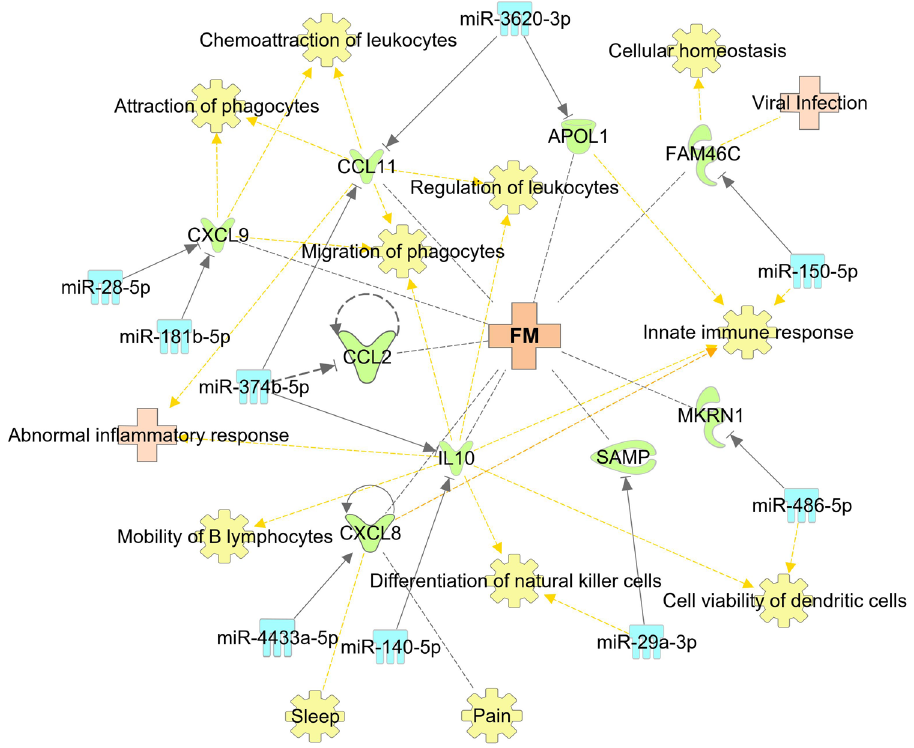
Figure 6. Genes related to ME/CFS or FM that are predicted or confirmed targets of the 11 miRNAs. The miRNAs are presented in light blue. The targets of miRNAs are in green, ME/CFS, FM and other related diseases are in light pink, and associated functions of genes are in